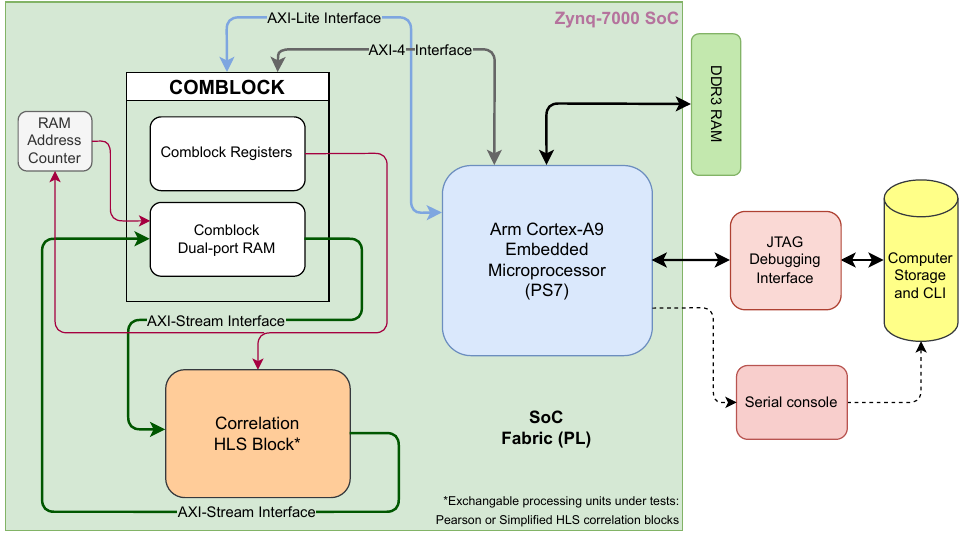
Figure 7. Hardware implementation block diagram with exchangeable IP processing blocks. The block named Correlation HLS block * represents the algorithms under test (PCI or SPCI), implemented as exchangeable IP cores developed using HLS. Each correlation index IP core was individually tested under the same